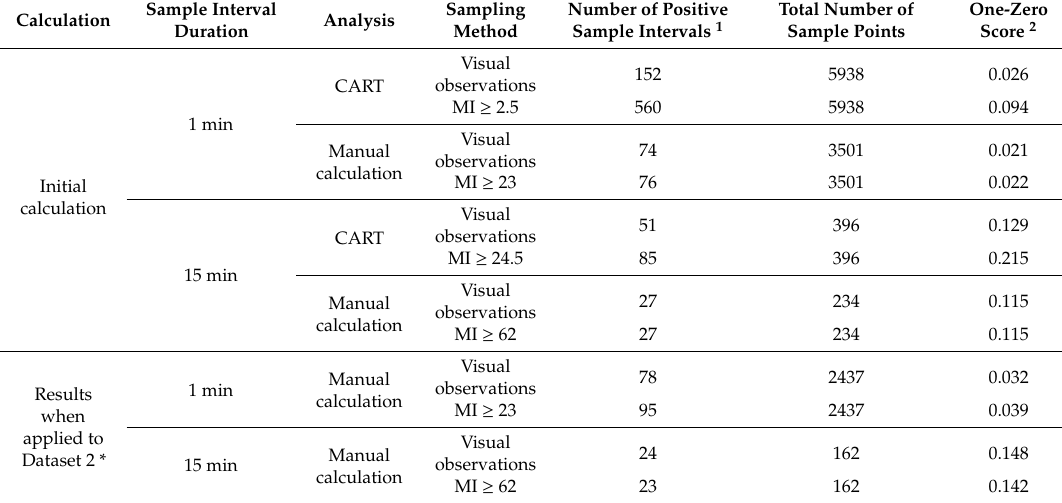
Table 6. Comparison of one-zero sampling score produced by visual observations (top row) and the equivalent score produced by motion index (MI) optimised for sensitivity / specificity (middle row), and that produced by MI optimised for one-zero sampling (lower row) for both 15 min and 1 min sampling